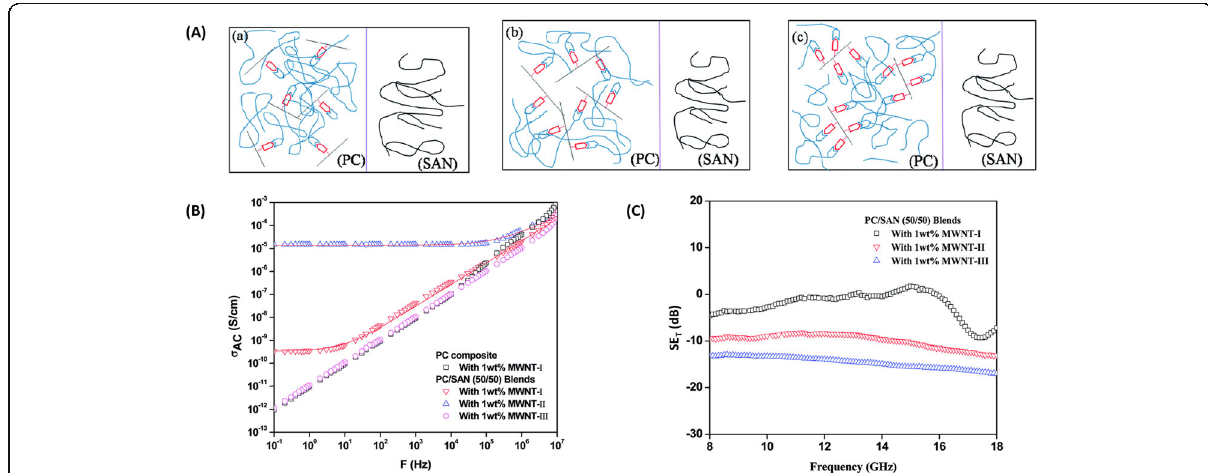
Fig. 12 (A) Schematic illustration of the effect of concentration of NH 2 terminal groups on the chain scission of PC ( a ) MWNT-I, ( b ) MWNT-II and ( c ) MWNT-III; ( B ) AC conductivity as a function of frequency for PC/SAN (50/50) blends with different MWNTs; ( C ) SE T for PC/SAN (50/50) blends with different types of MWNTs. Reprinted with permission from Bose et al. [57], copyright 2014 Royal Society of